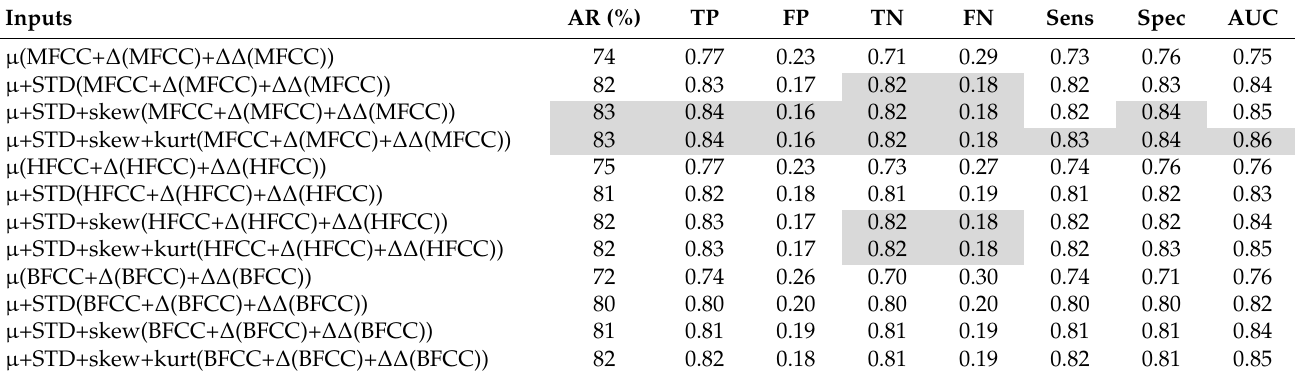
Table 4. Evaluation of the RF model with MFCC, HFCC and BFCC filters, by incrementally employing the first four moments of their distributions (mean- µ , standard deviation-STD, skewness-skew and kurtosis-kurt), together with their ∆ and their ∆∆ . 10-cross-validation with 20,000 laughs (18,000 training and 2000 test in 10 epochs). AR, accuracy rate; TP, true positive; FP, false positive; TN, true negative; FN, false negative; Sens, sensitivity; Spec, specificity. Best performance per column is highlighted in bold.